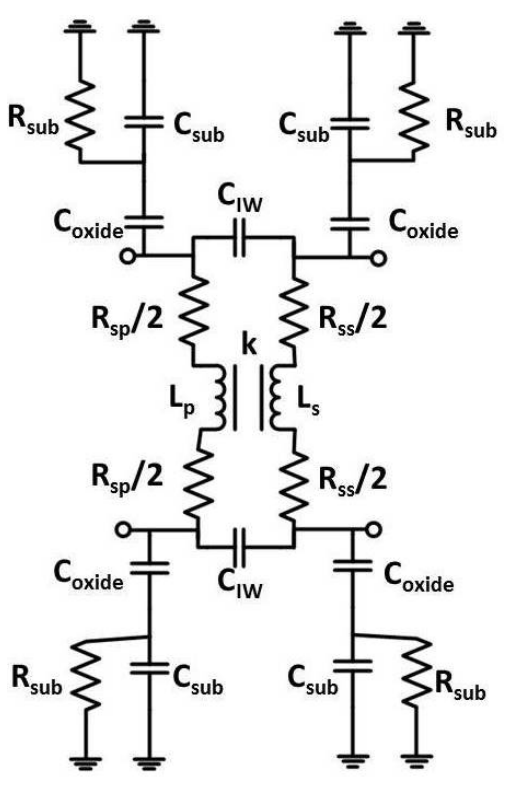
Figure 3. Basic model of